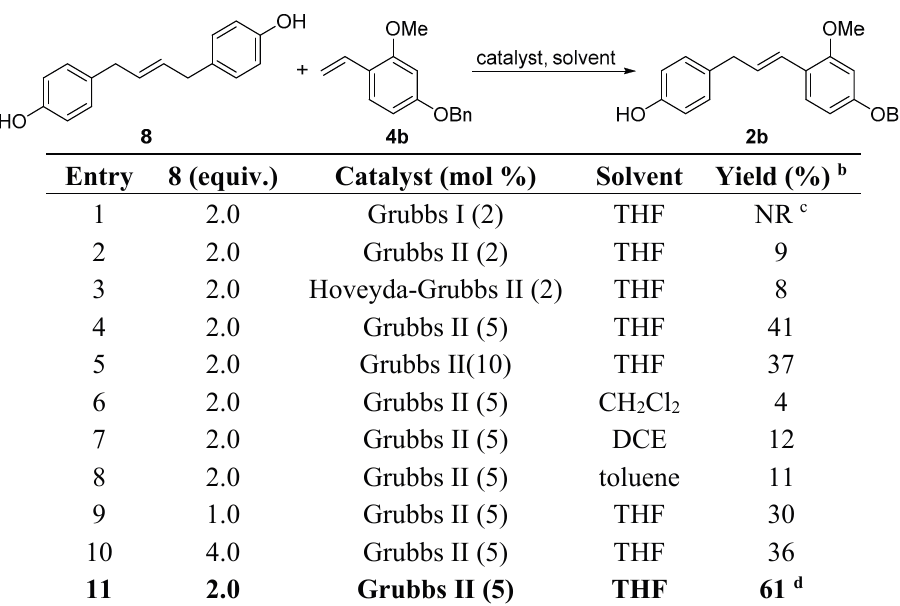
Table 1. Optimization of cross metathesis reaction a